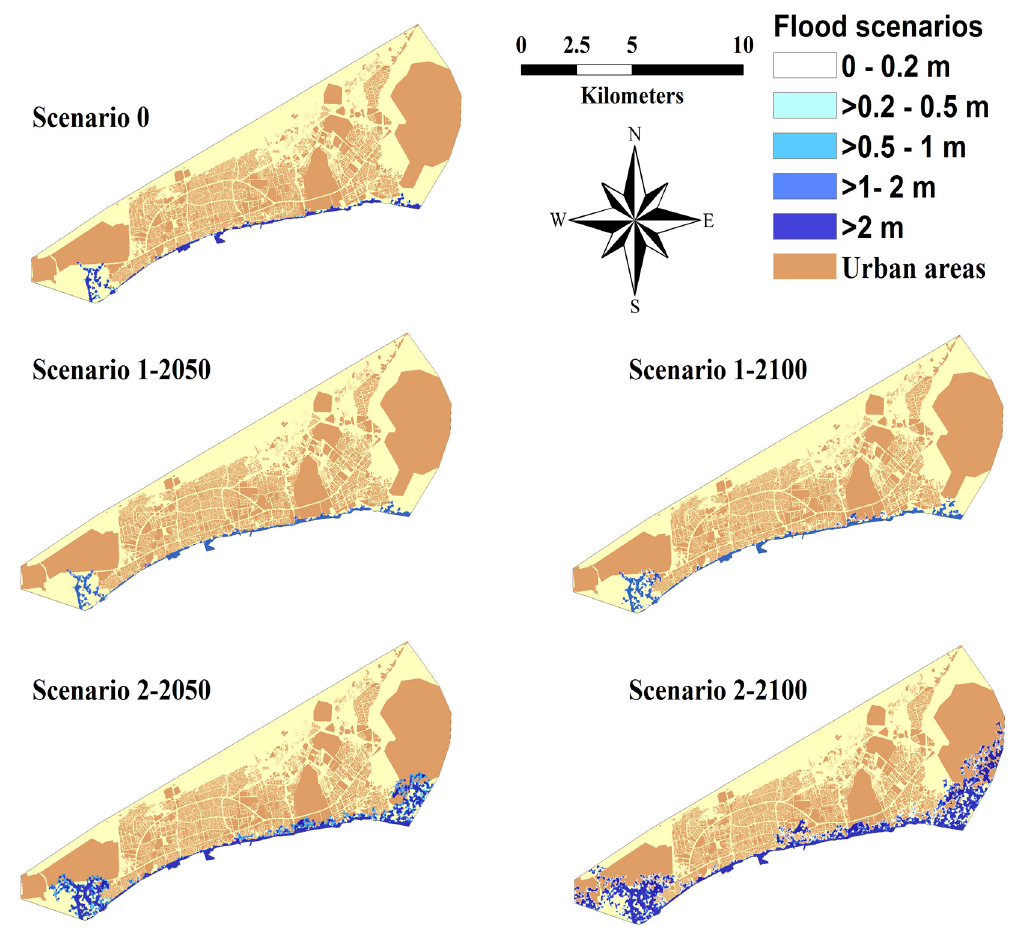
Figure 3. Flooded areas under various scenarios in Bandar Abbas City.